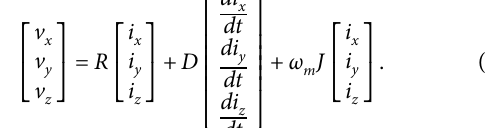
and ψ are self-inductance flux linkage x , x y , y and ψ are mutual x , y y , x